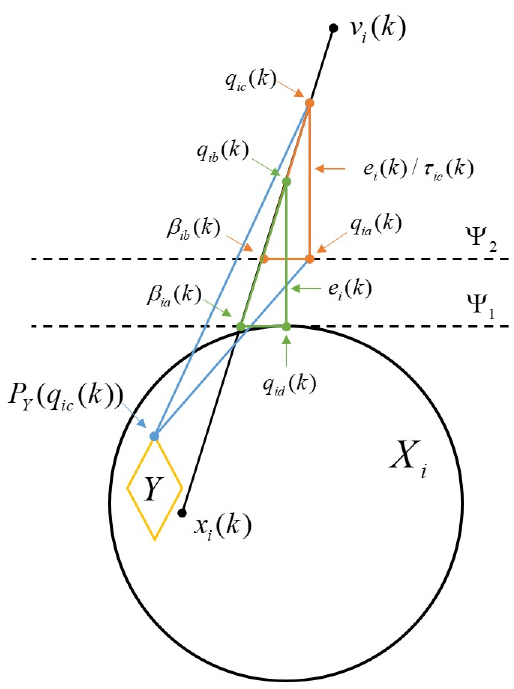
Figure 2. Example of similar triangles.